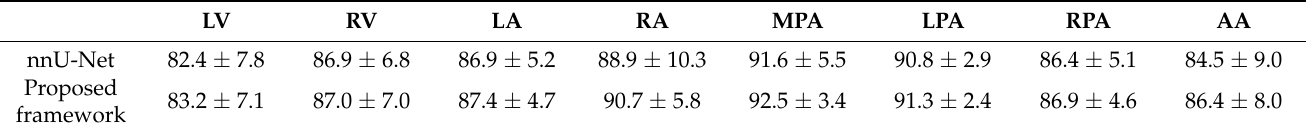
Table 2. Dice score between the original nnU-Net and the proposed